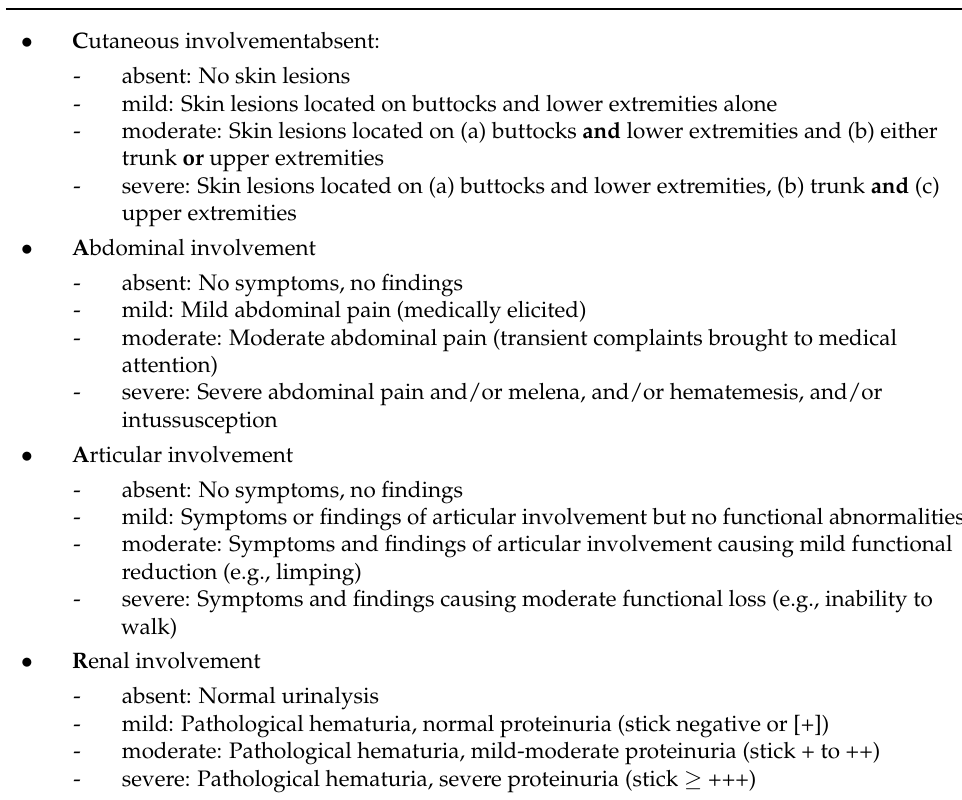
Table 1. CAAR grading for C utaneous, A bdominal, A rticular and R enal involvement in Henoch– Schönlein syndrome. The involvement is graded as absent, mild, moderate, or severe